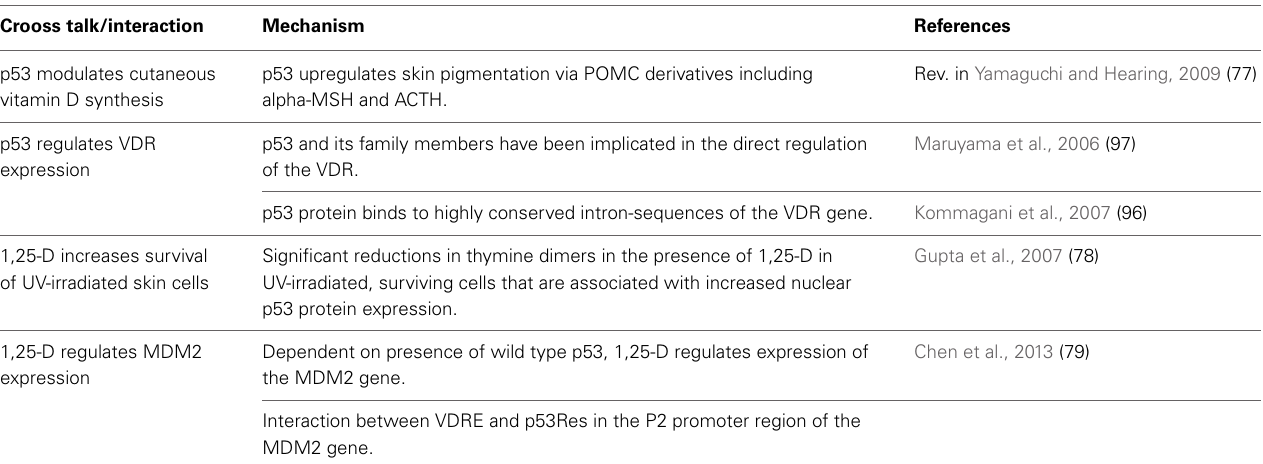
Table 1 | Overview of the cross talk between vitamin D- and p53